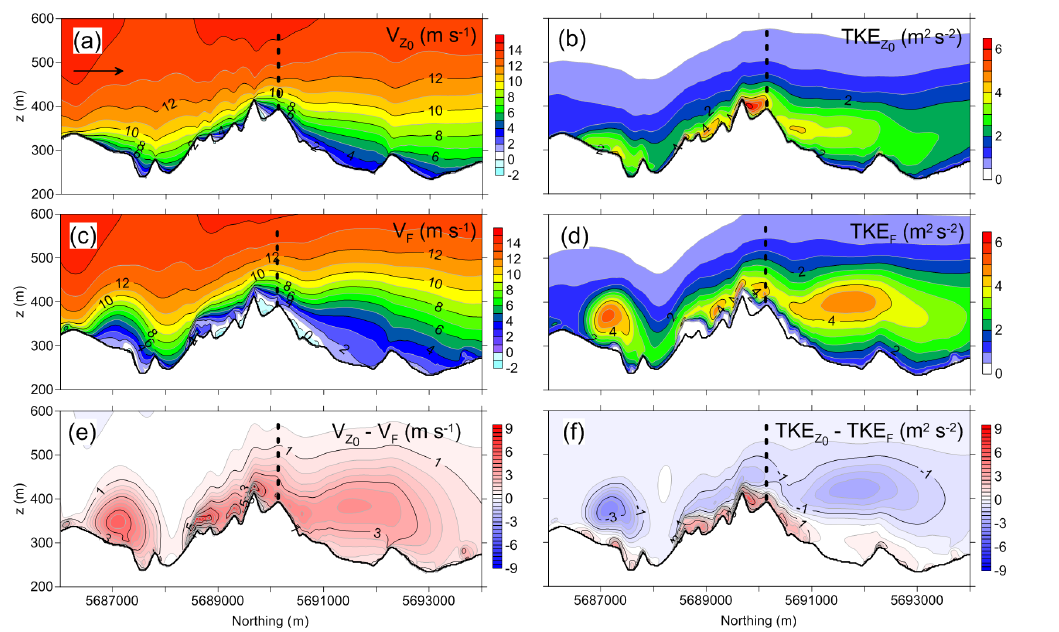
Figure 8. Two-dimensional fields of (a, c) northward component of wind speed ( V ) and (b, d) turbulent kinetic energy (TKE) along the south-north transect (see location in Fig. 3b) modelled by EllipSys3D using the effective roughness (subscript z 0 ) and the canopy drag (subscript F ) approaches. The differences in values of V and TKE derived using two different approaches are also shown in (e) and (f) , respectively. Arrow in (a) shows the flow direction. Thick black lines in panels indicate the surface. Dashed lines in panels indicate the met mast position.